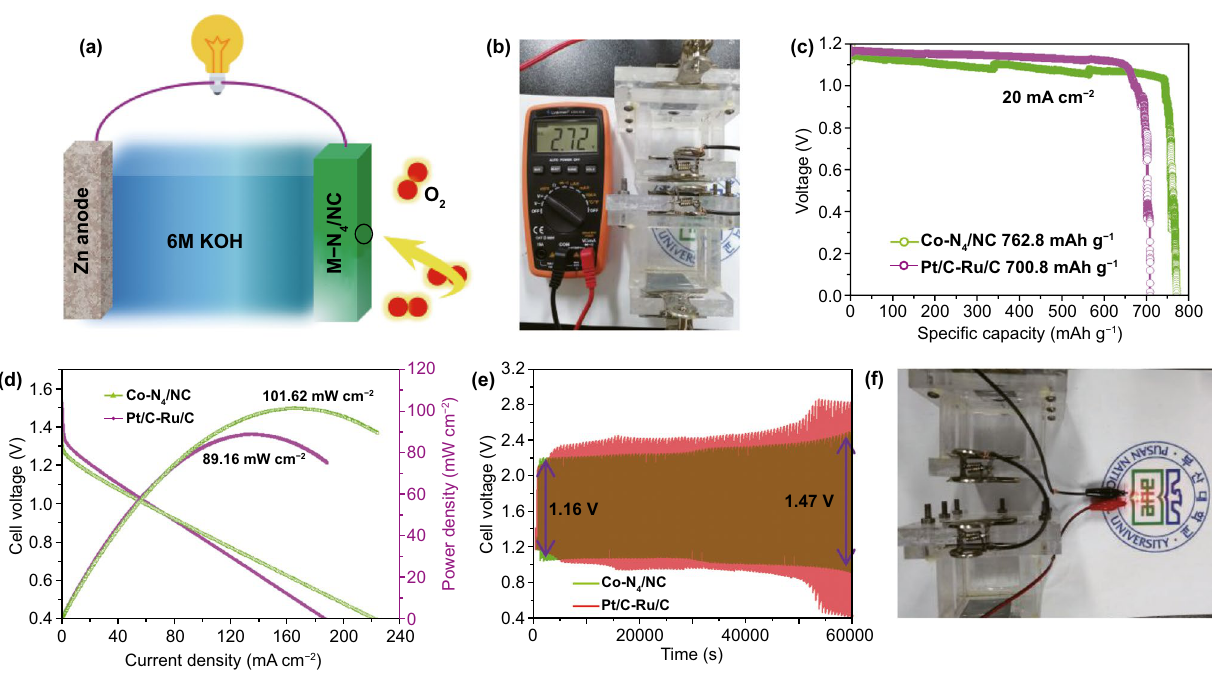
Fig. 8 a Schematic of zinc–air battery. b Open cell voltage (OCV) of two-connected Zn–air battery. c Specific discharging capacities at 20 mA cm −2 . d Discharging polarization and power density curves based on the Co-N 4 /NC and Pt/C-Ru/C catalyst. e Cycling test (100 cycles) at a current density of 10 mA cm −2 with Co-N 4 /NC and Pt/C-Ru/C catalyst. f Images of two homemade rechargeable Zn–air batteries in series with a